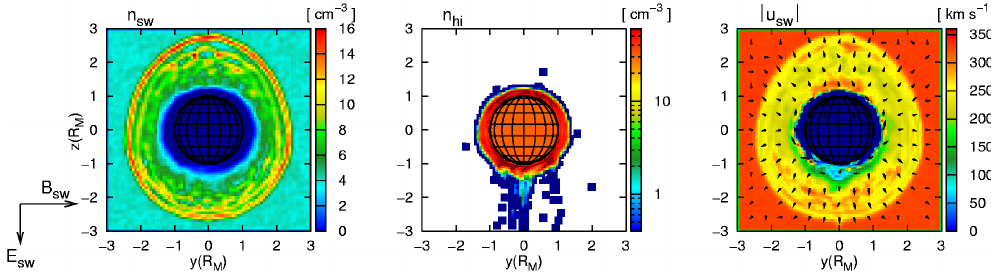
Fig. 7. Simulation results in the terminator plane. The subfigures represent the same parameters like in Fig. 6. The solar wind comes from behind the paper plane. The oval shape of the bow shock is due to the propagation of the fast magnetosonic wave which depends stronly on the direction of the